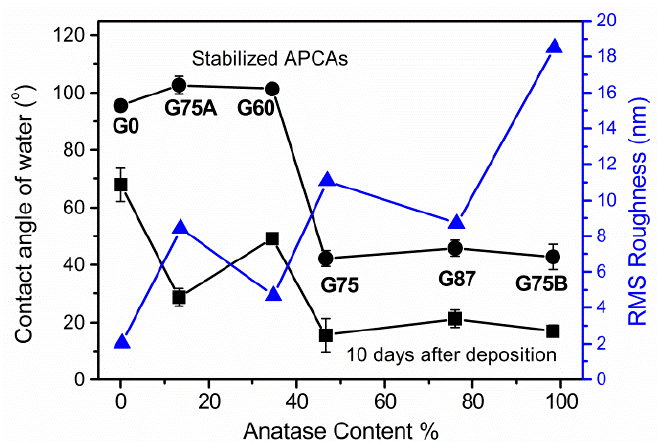
Figure 6. Apparent water contact angles of the GLAD TiO 2 films, 10 days after the deposition and >30 days after deposition (stabilized), along with the respective RMS surface roughness (in nm), as a function of the TiO 2 phase composition.